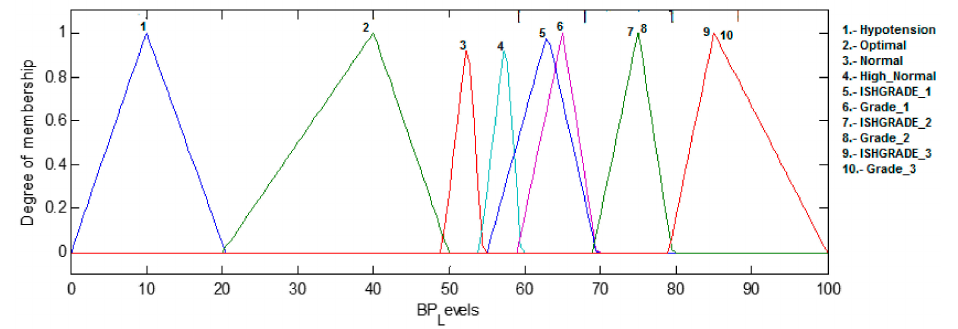
Figure 14. BP_Levels is the output of the fuzzy logic classifier